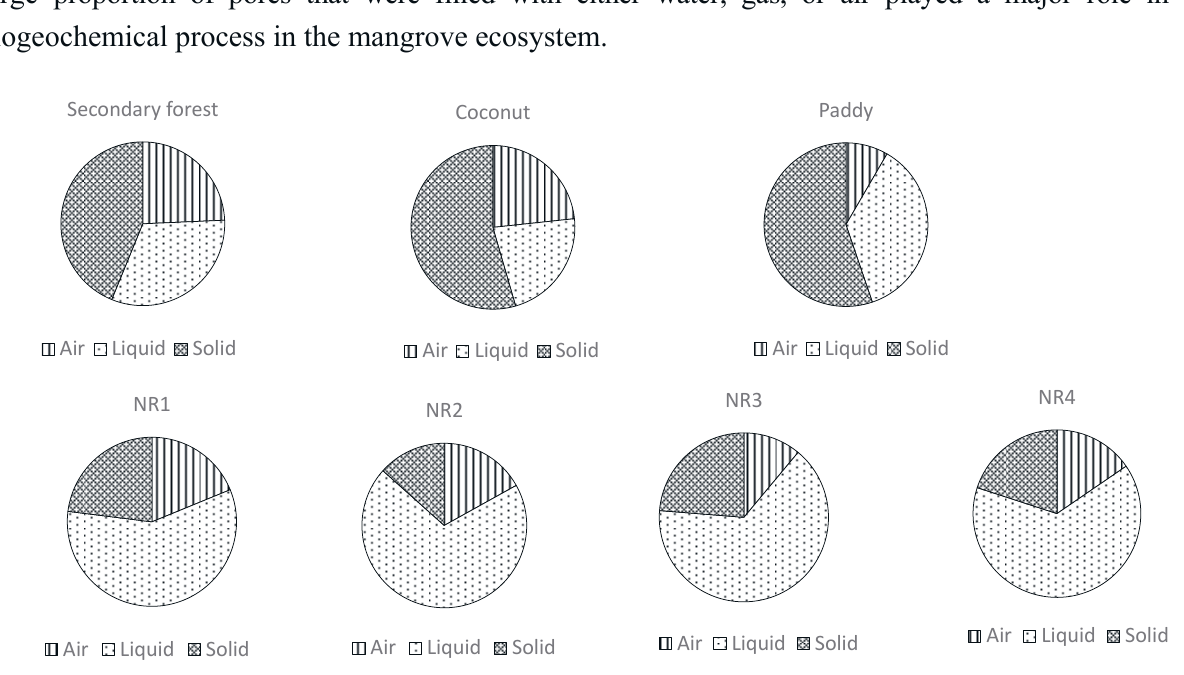
Figure 3. Three-phase distributions of soils collected at 5 cm soil depth from seven places. Top pie charts are for the terrestrial ecosystem (secondary forest, coconut plantation, and PF), and bottom ones are for the mangrove ecosystem.